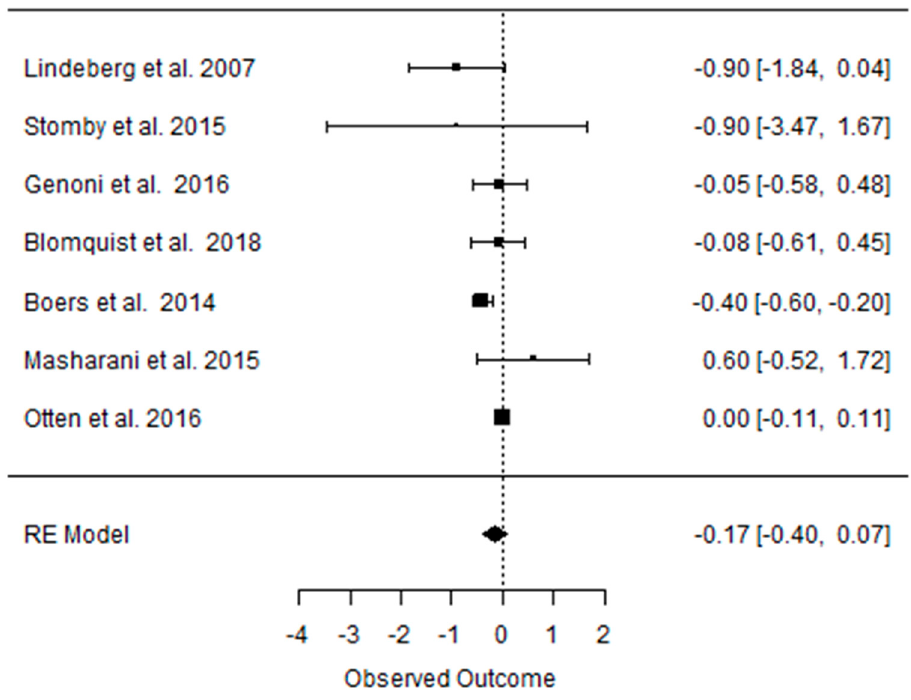
Figure A46. Forest plot of the effect of a CD on fP glucose (mmol/L) in the short term (weighted mean difference).